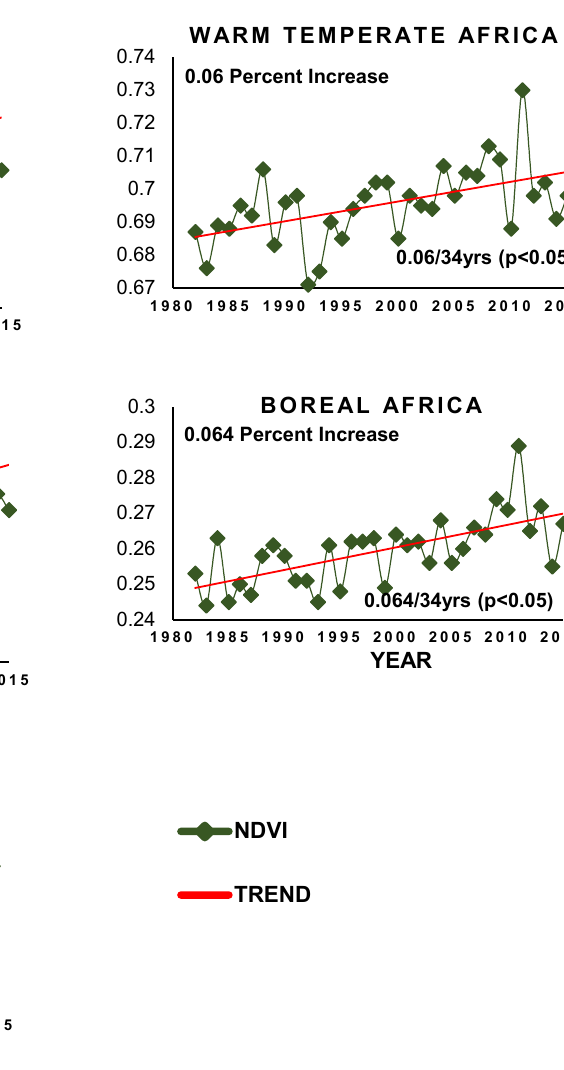
Figure 2. Statistical analysis of Normalized Difference Vegetation Index-3rd generation trends values in all the climate zones of